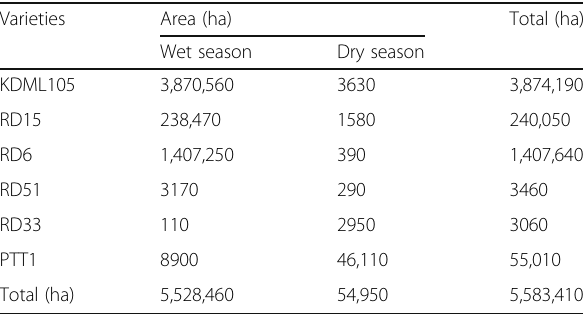
Table 3 Planting area of the Thai Jasmine rice (KDML105 + RD15), KDML-derived varieties, RD6, RD51, RD33, and Pathumthani 1 (PTT1), in the wet and dry seasons, 2013 – 14 (Unpublished Rice